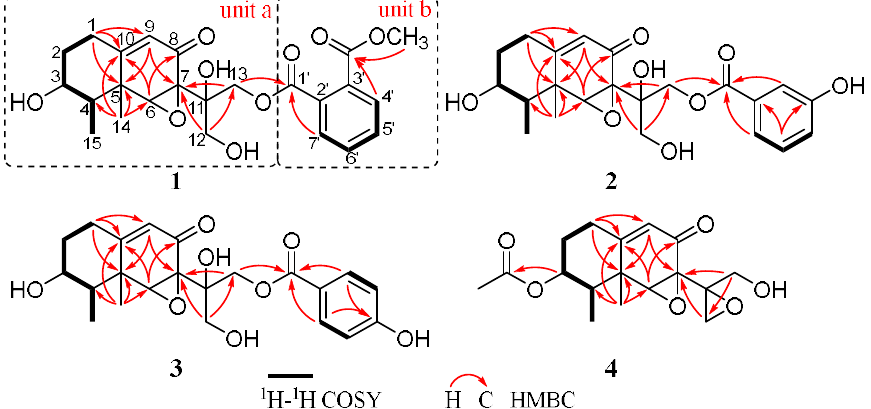
Figure 2. Key HMBC and 1 H- 1 H COSY correlations of compounds 1 – 4 .